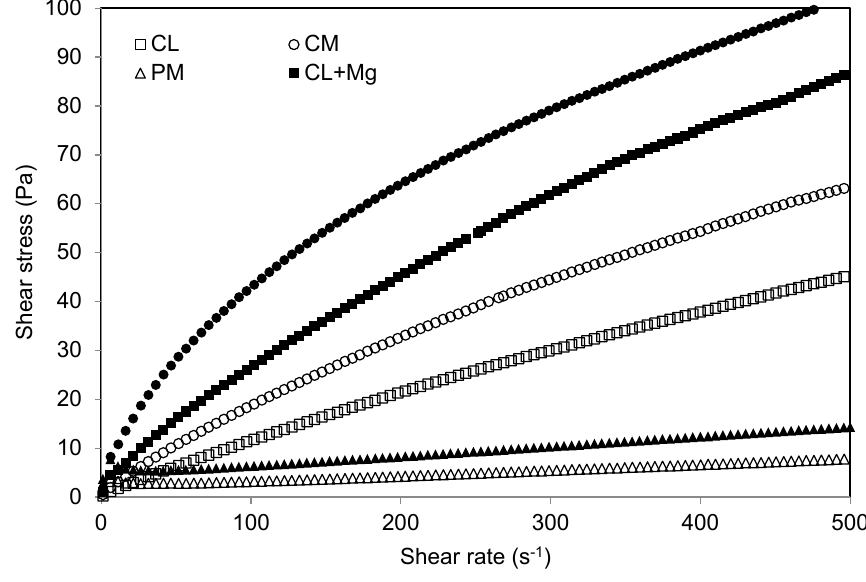
Figure 2. Flow curves of chia O/W emulsions. Average values ( n =